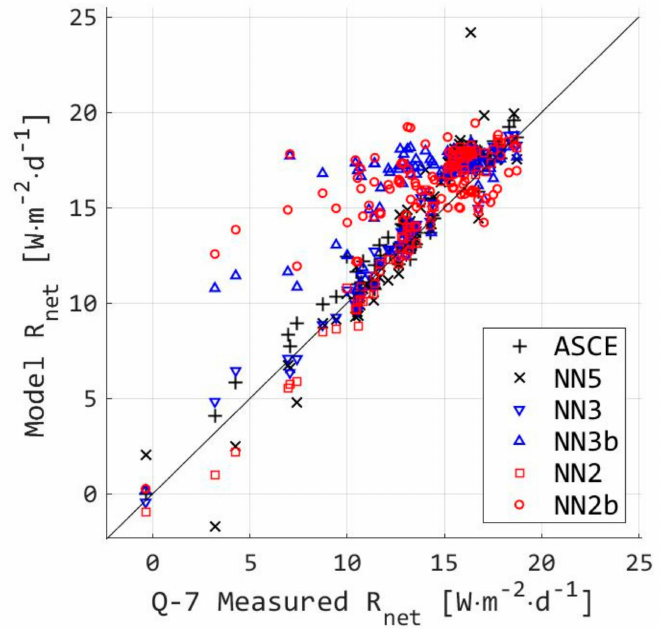
Figure 10. Daily net radiation measured by Q-7 sensor compared to the NN models and standardized net